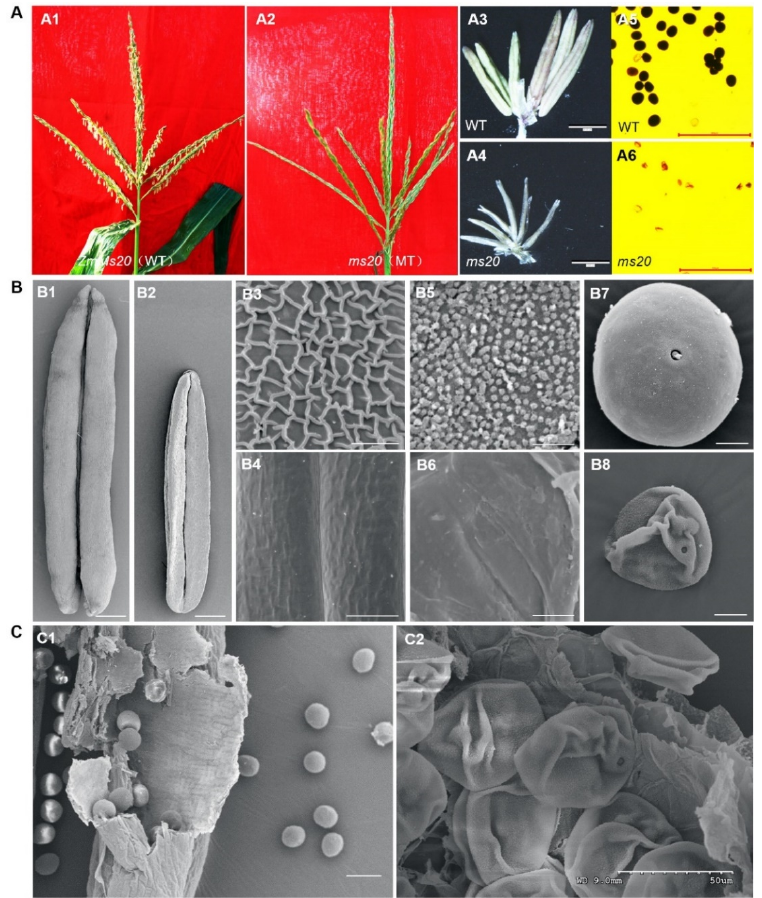
Figure 1. Phenotypic comparison of maize tassels, anthers, and pollen grains between wild type (WT) and ms20 mutant at anthesis stage. ( A ) Tassels ( A1 and A2 ), spikelet ( A3 and A4 ), and pollen grains stained with I 2 -KI solution ( A5 and A6 ) of WT and ms20 . Bars = 2.5 mm in A3 and A4 , 500 µ m in A5 and A6 . (B ) SEM analysis of WT and ms20 anthers and pollen grains at anthesis stage. ( B1 , B2 ) The ms20 anther ( B2 ) is smaller and wilted than that of WT ( B1 ). ( B3 , B4 ) The outer surface of ms20 anther ( B4 ) is glossy compared with that of WT ( B3 ). ( B5 , B6 ) Ubisch bodies ( B5 ) were observed on the inner surface of WT anther but none on the ms20 anther ( B6 ). ( B7 , B8 ) The WT pollen grain is round-shape ( B7 ), while ms20 pollen is wizened in the locule ( B8 ). Bars = 500 µ m in B1 and B2 , 5 µ m in B3 and B4 , 2 µ m in B5 and B6 , and 10 µ m in B7 and B8 . ( C ) SEM analysis of WT and ms20 pollens at anthesis stage. For C1 and C2 , WT pollens ( C1 ) are spread out, but ms20 pollens ( C2 ) are stuck on the inner surface of anther locule. Bars = 100 µ m in C1 , and 50 µ m in C2